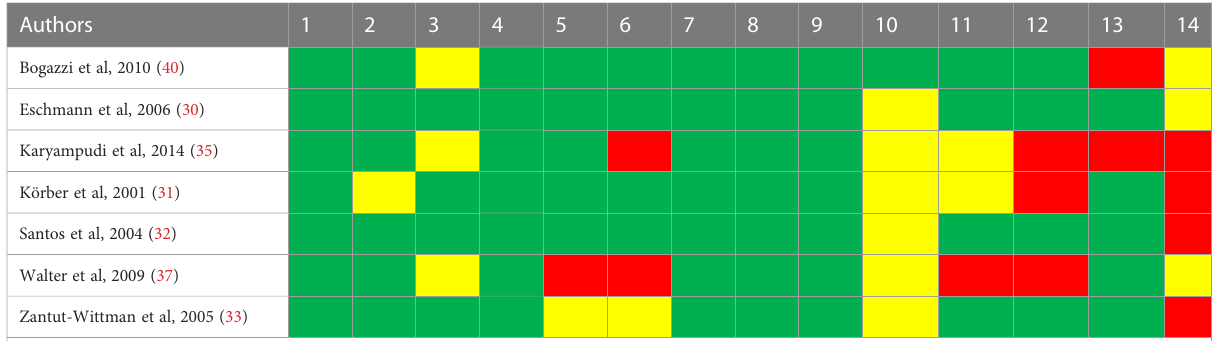
TABLE 5 Critical Appraisal Skills Programme Cohort Study checklist.